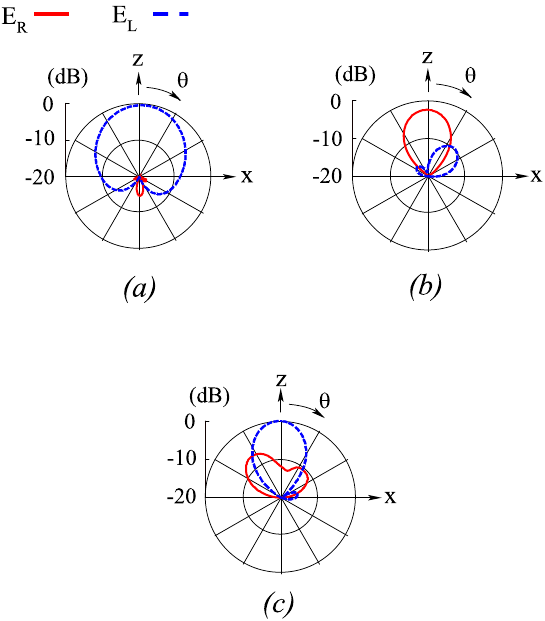
Fig. 26. Radiation pattern for the square metaloop-N antenna (SQR-MTLP-N). (a) At 2.55 GHz= f N1 . (b) At 3.55GHz near f H1 =3.475 GHz. (c) At